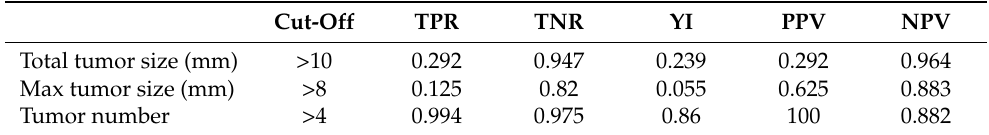
Table 4. Boundary values of different factors in predicting bilateral tumor manifestation in patients Table 3. ROC Analysis of the predictive value of the risk factors for total tumor size, Maximum with papillary tumor size, and Tumor number for bilaterality.